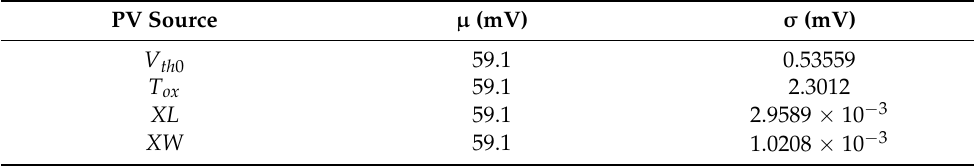
Table 2. The statistical characteristics of ∆ V th by separate PV source.